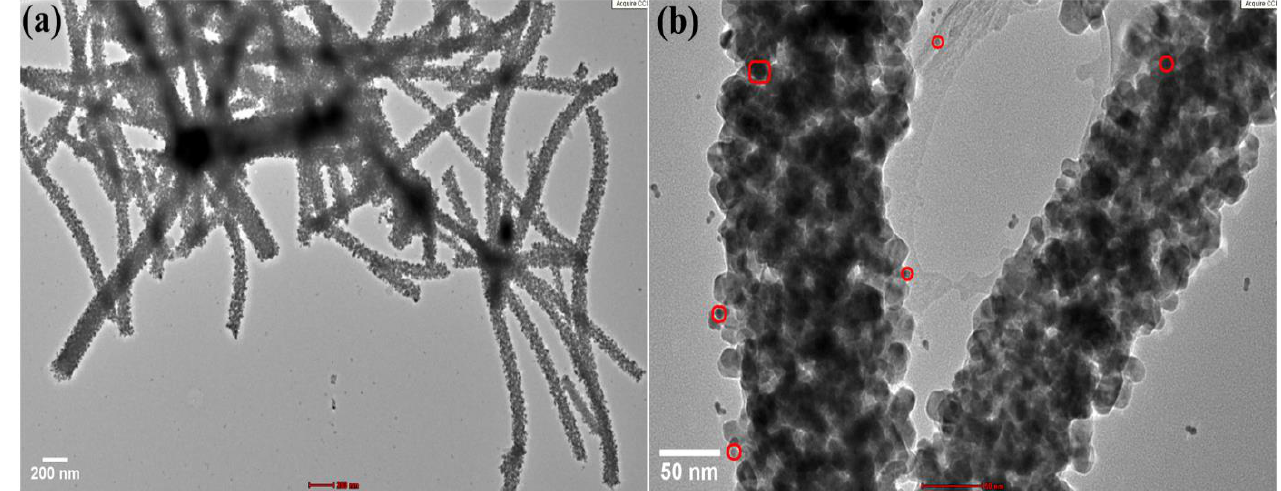
Figure 2. Au NPs – SnO 2 NFs composite under TEM analysis ( a ) ×5000, and ( b ) ×50,000. Figure 2. Au NPs–SnO 2 NFs composite under TEM analysis ( a ) × 5000, and ( b ) ×